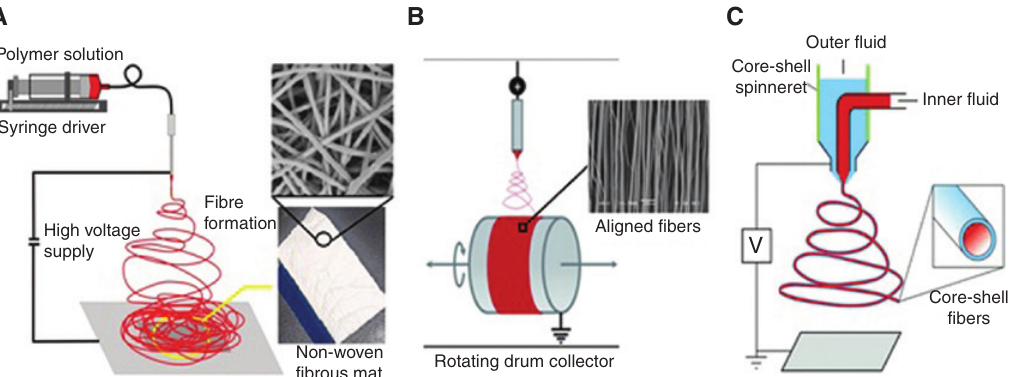
Figure 1: (A) Conventional electrospinning setup to obtain random nanofibers; (B) aligned fibers obtained by a rotating drum collector; (C) core-shell structured fibers generated by a core-shell